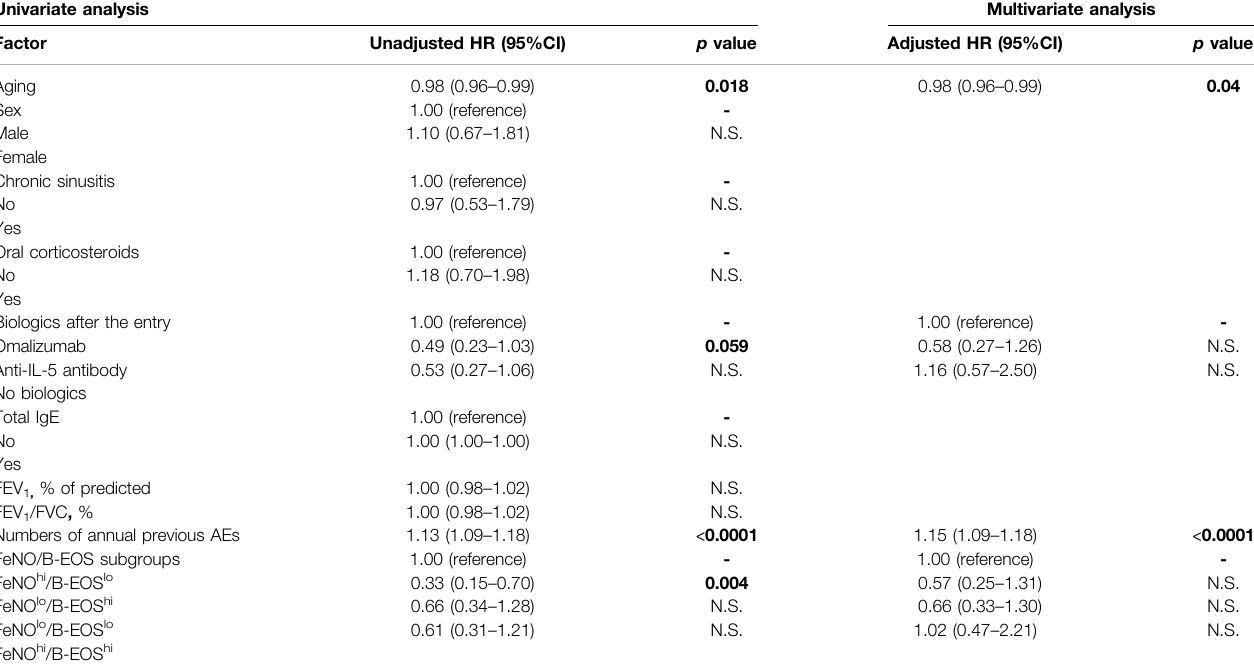
TABLE3| UnivariableandmultivariableCoxproportionalhazardmodelstodeterminethehazardratioforthesubsequentasthmaexacerbation-freetimeintheFeNO/B-EOS subgroups.